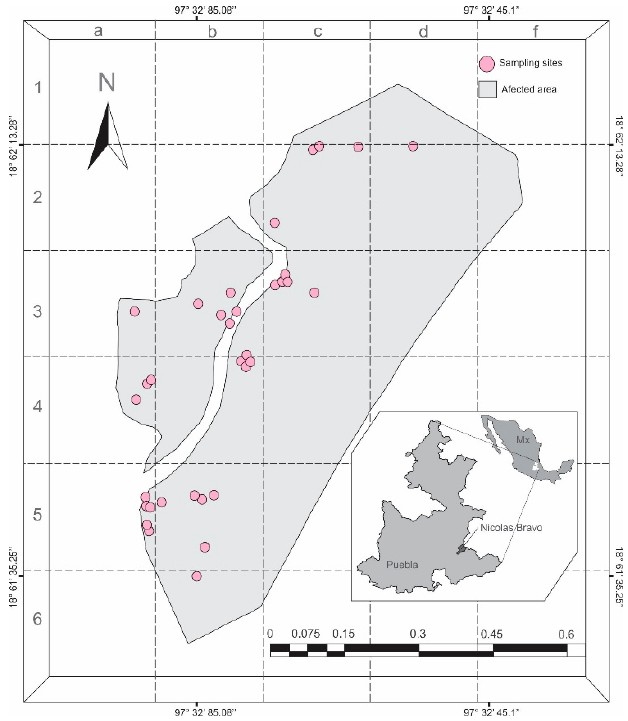
Figure 1. Map of sample sites of Ocoaxo assimilis in Nicolas Bravo, Puebla. Each pink circle represents an area, where a quadrant of 9 × 9 m was sampled.